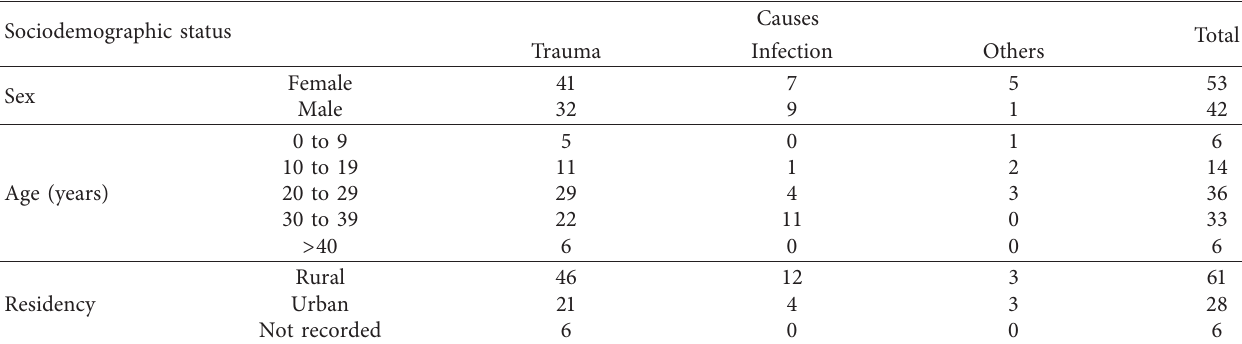
Figure 1: Causes and duration of TMJA. The causes (a) and time from the onset to the presentation of patients to the clinic (b). Table 2: Sociodemographic characteristics and causes of TMJA.